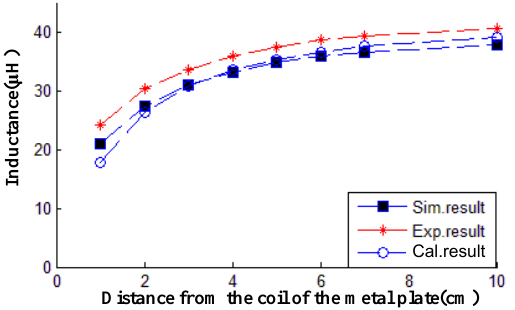
Figure 6. Effect of different distances between the receiving coil and the metal plate on the coil inductance.